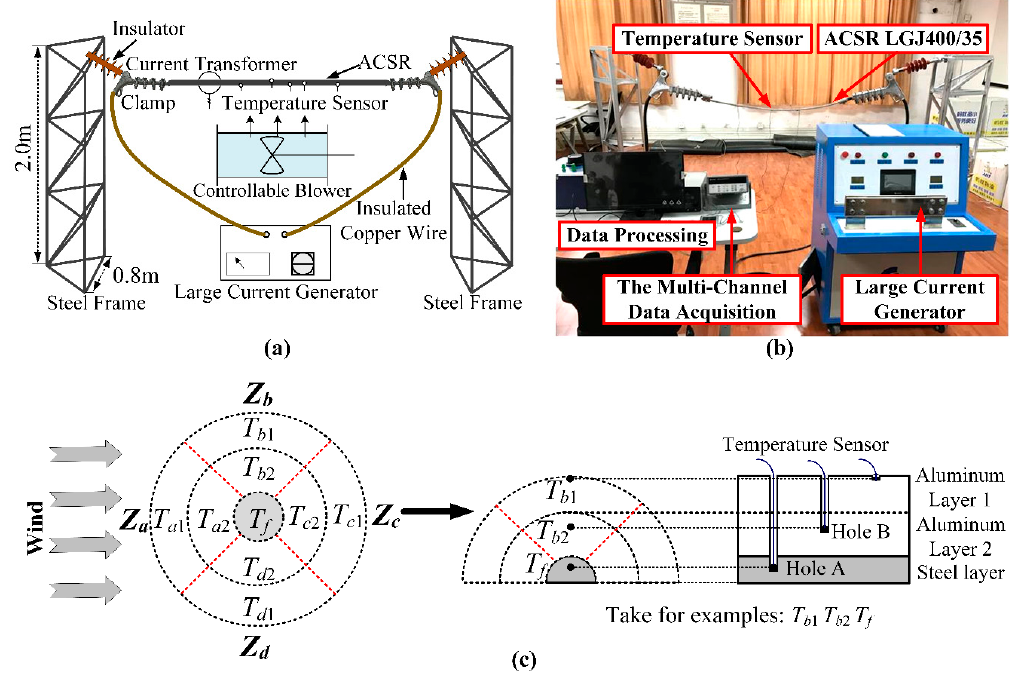
Figure 5. Test platform of overhead transmission line temperature measurement. ( a ) Platform schematic; ( b ) Platform photo; ( c ) Diagram of temperature measuring point position.